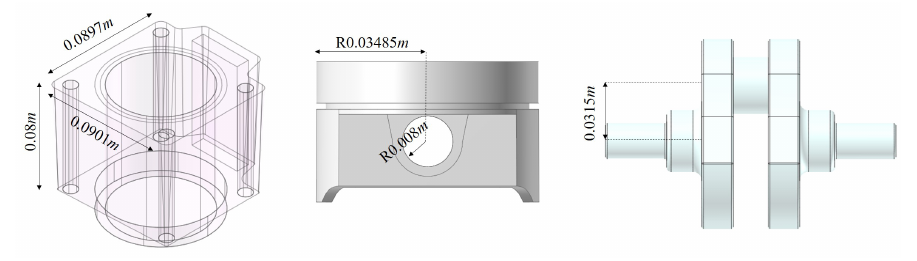
Figure 12. Main dimensions of the bodies.